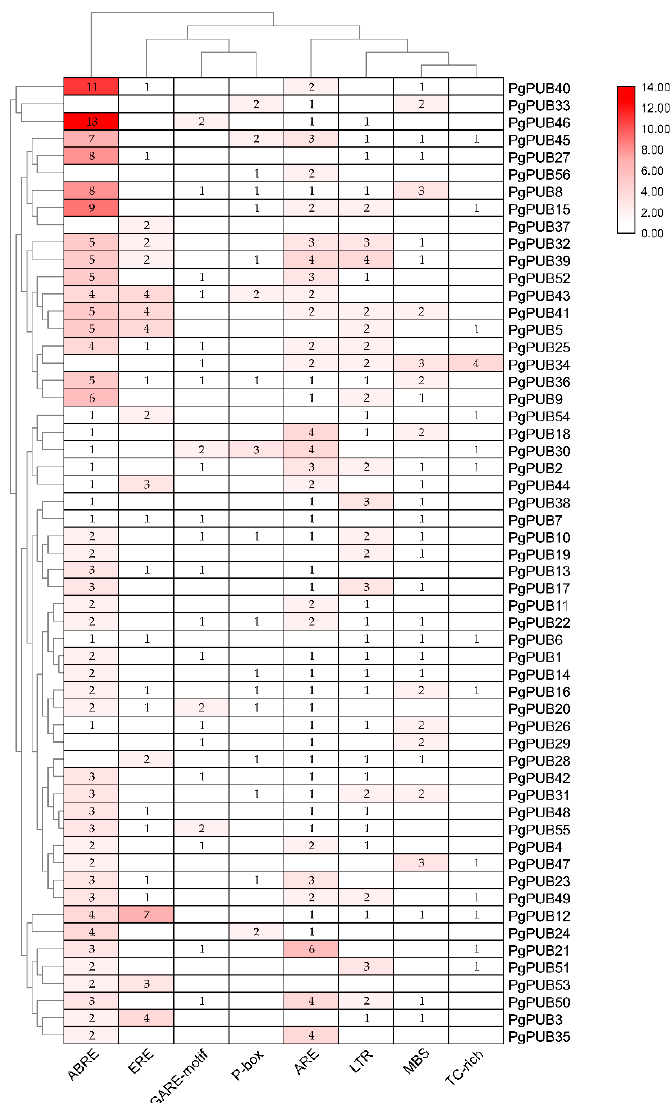
Figure 3. Cis-regulatory elements analysis of PgPUB family members. Promoter sequences (2000 bp) of 56 PgPUB genes analyzed by PlantCARE. The number in the box indicates the frequency of cis-elements in the promoter region.